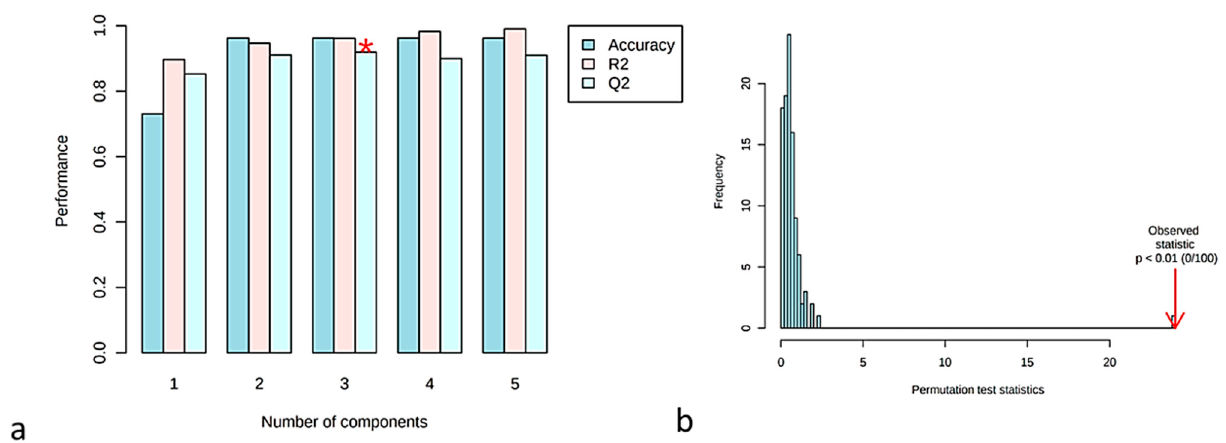
Figure 5. ( a ) Cross validation parameters of the developed PLS-PDA model with the prediction error measure: accuracy, R2, Q2 (The accuracy = 0.96, was obtained from the third component shown with asterisk.); ( b ) Permutation test statistics (100 random permutations).